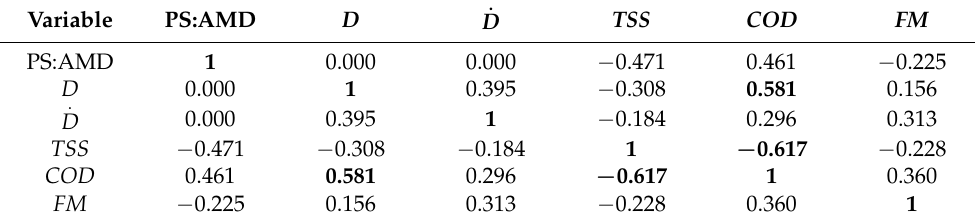
Table 4. Correlation matrix (Spearman = r s ) of the investigated variables.